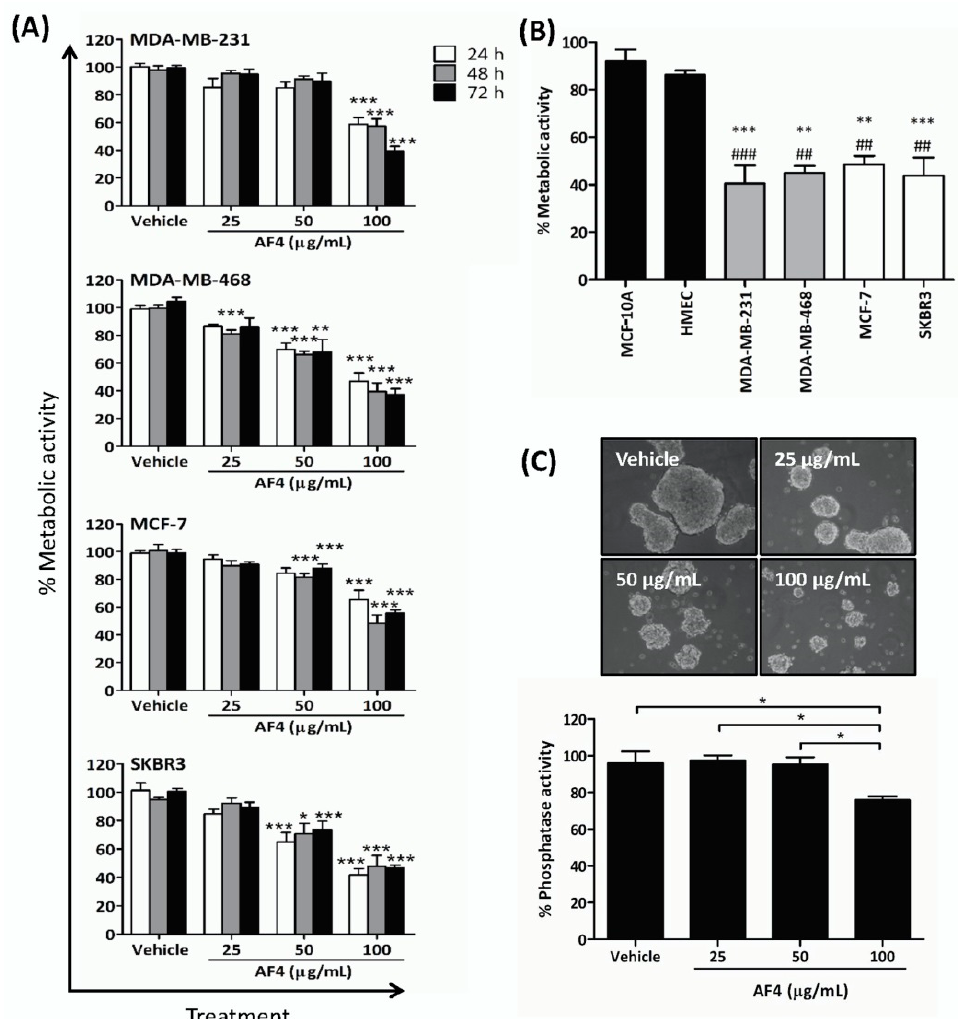
Figure 1. Apple peel flavonoid fraction 4 (AF4) is selectively cytotoxic to breast cancer cells. ( A ) MDA-MB-231, MDA-MB-468, MCF-7 and SKBR3 cells were cultured in the absence or presence of the indicated concentrations of AF4 for the indicated times. The % metabolic activity of AF4-treated cells was determined using an MTT (3-(4,5-dimethythiazol-2-yl)-2,5-diphenyltetrazolium bromide) assay. Data are expressed as mean ± standard error of the mean (SEM). ( B ) The % metabolic activity of AF4-treated (100 µ g / mL) breast cancer cells was compared to MCF-10A cells (#) and HMECs (*) cells. Data from MTT assays are expressed as mean ± SEM. ( C ) MCF-7 spheroids were cultured for 72 h